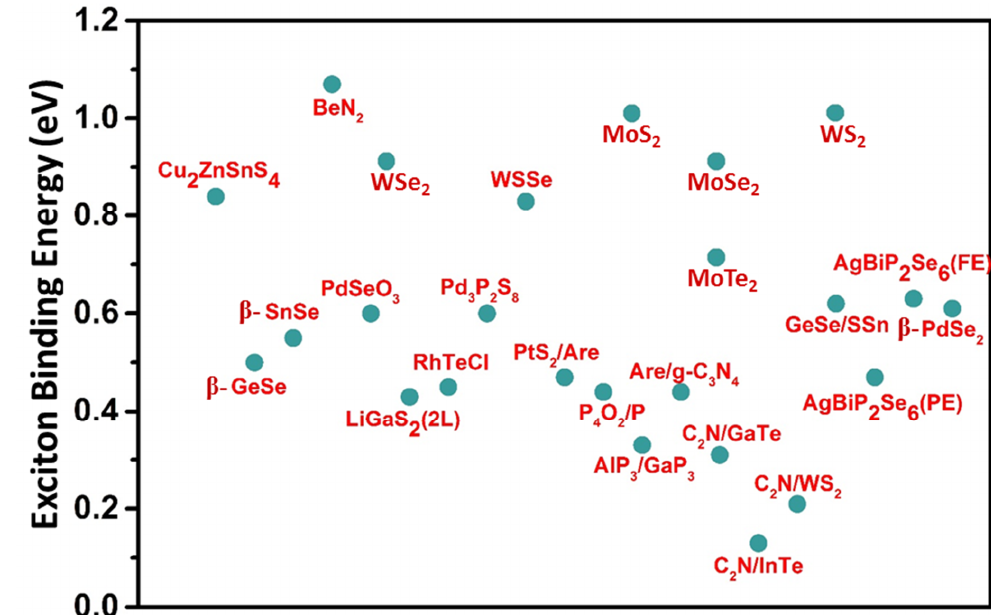
Figure 4. The calculated exciton binding energy of 2D materials.